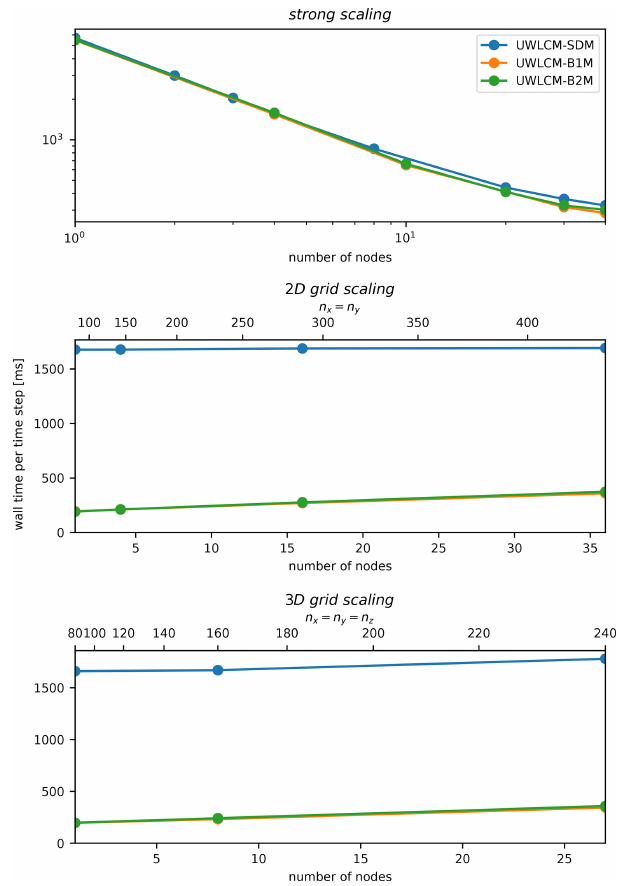
Figure 6. Multi-node model performance for different microphysics schemes. Wall time per model time step averaged over 100 time steps. Results of LES of a rising thermal done on the Prometheus cluster for different scaling